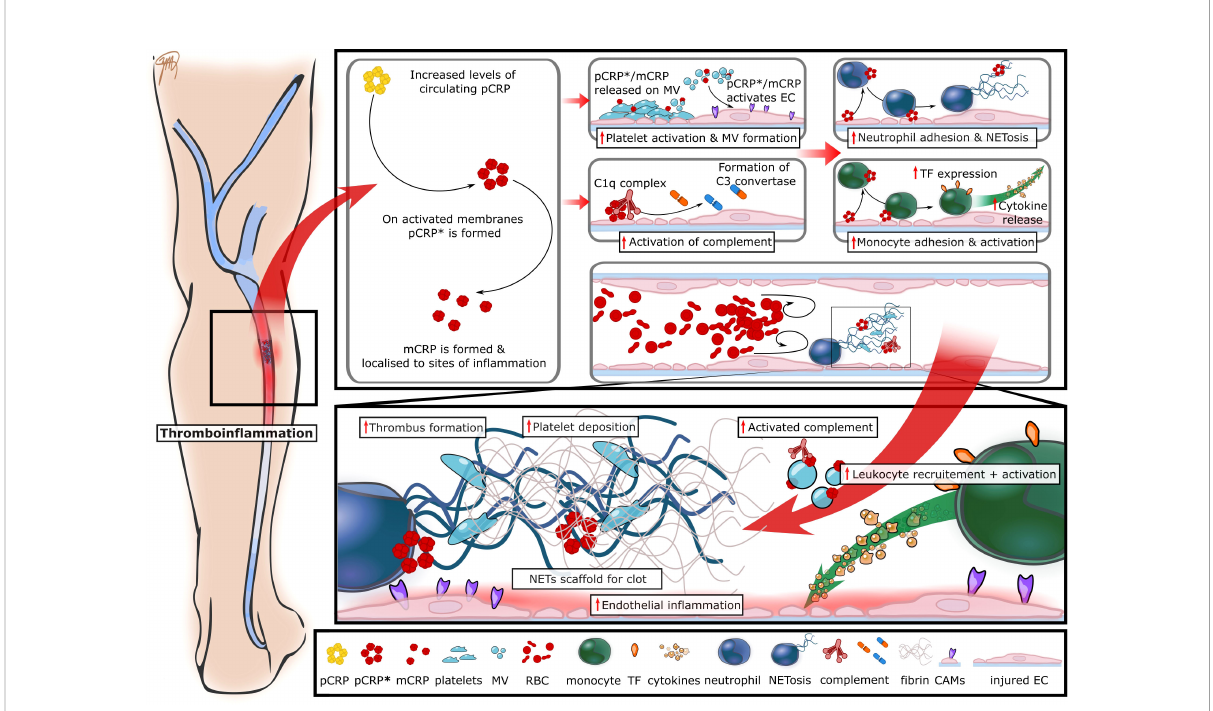
FIGURE 1 The proposed role of CRP in immunothrombosis and VTE pathogenesis. The inciting events leading to VTE formation are endothelial in fl ammation with the subsequent recruitment of platelets and leukocytes. Leukocytes provide a source of tissue factor (TF) and highly activated neutrophils undergo NETosis, thereby resulting in thrombin formation and the generation of fi brin. Circulating CRP levels rapidly increase in the setting of in fl ammation and pCRP binds to disturbed cell surfaces, such as in fl amed endothelial cells (EC) and activated platelets where it dissociates into the pro-in fl ammatory and pro-thrombotic isoforms pCRP* and mCRP. These pro-in fl ammatory isoforms amplify further activation of the endothelium, platelets and bind to complement C1q, thereby initiating complement activation. These changes result in further recruitment and activation of leukocytes ultimately leading to increased tissue TF and NET formation, thus resulting in enhanced thrombus formation. CAMs, cell adhesion molecules; EC, endothelial cells; MV, microvesicles; RBC, red blood cells; CRP, C-reactive protein; pCRP, pentameric CRP; pCRP*, neoepitope expressing pCRP; mCRP, monomeric CRP; NETs, neutrophil extracellular traps; TF, tissue